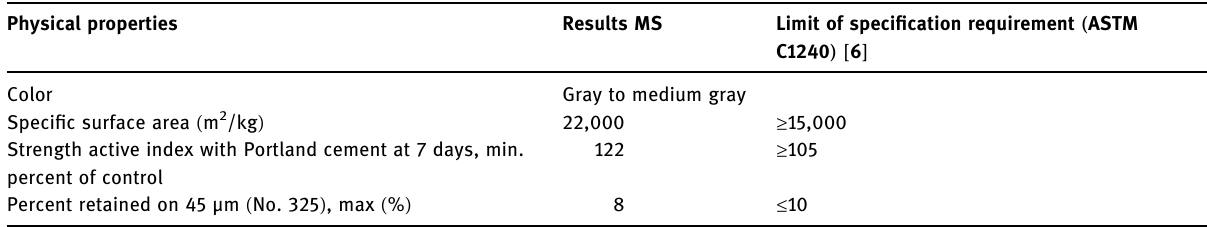
Table 6: Physical properties and requirements of micro silica